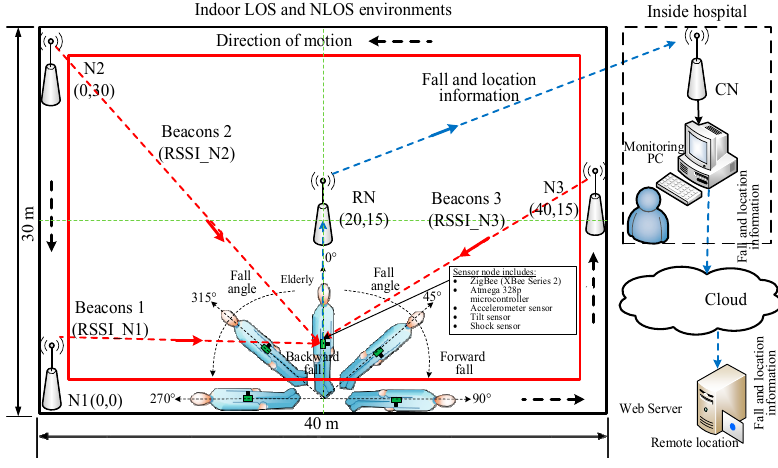
Figure 1. Topology of WSN of the subject fall and localization system.